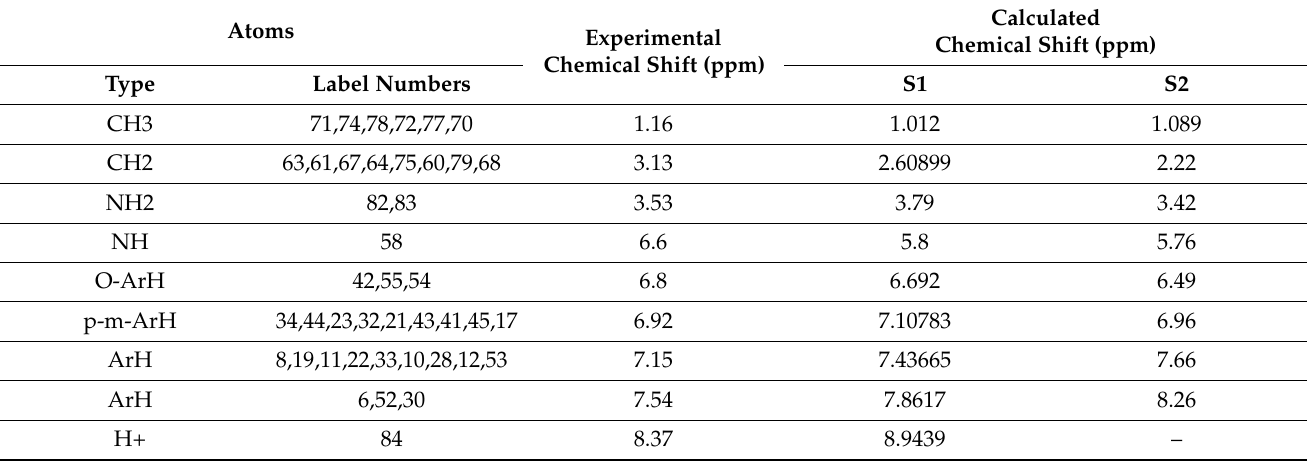
Table 5. Experimental and theoretical (B3LYP/6-311 + G(d,p)) GIAO 1 H chemical shift values (with respect to TMS, all values in ppm) of the proposed complex.